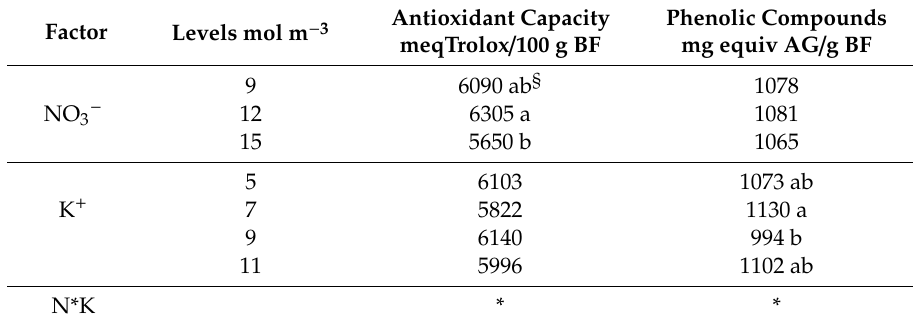
Table 2. Antioxidant capacity and phenolic compounds in strawberry fruit with di ff erent levels and interactions of N and K in the nutrient